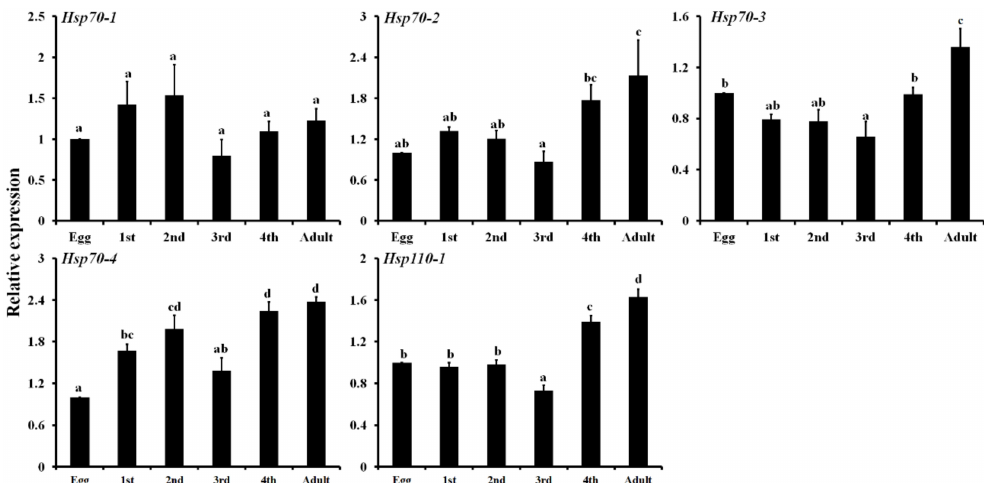
Figure 4. Developmental expression pattern of the five Hsps genes in Liposcelis bostrychophila . Each value represents the mean ( ± SE) of three replications. Di ff erent letters above the error bar for each gene show significant di ff erence ( p < 0.05).